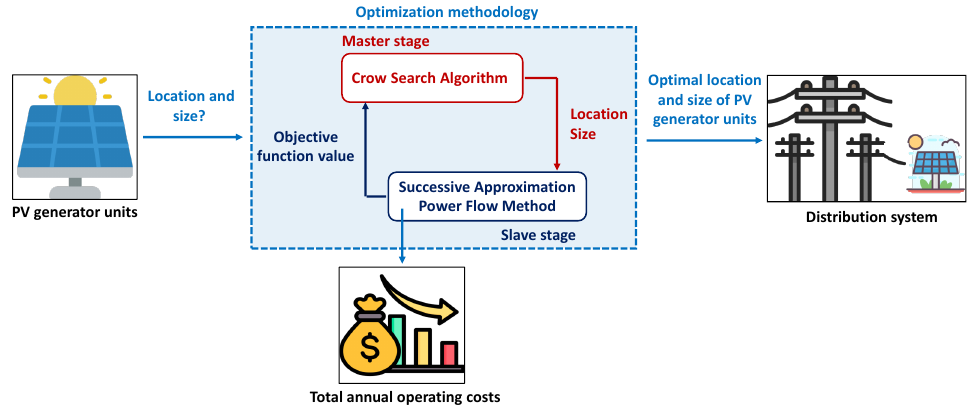
Figure 1. Graphic proposed